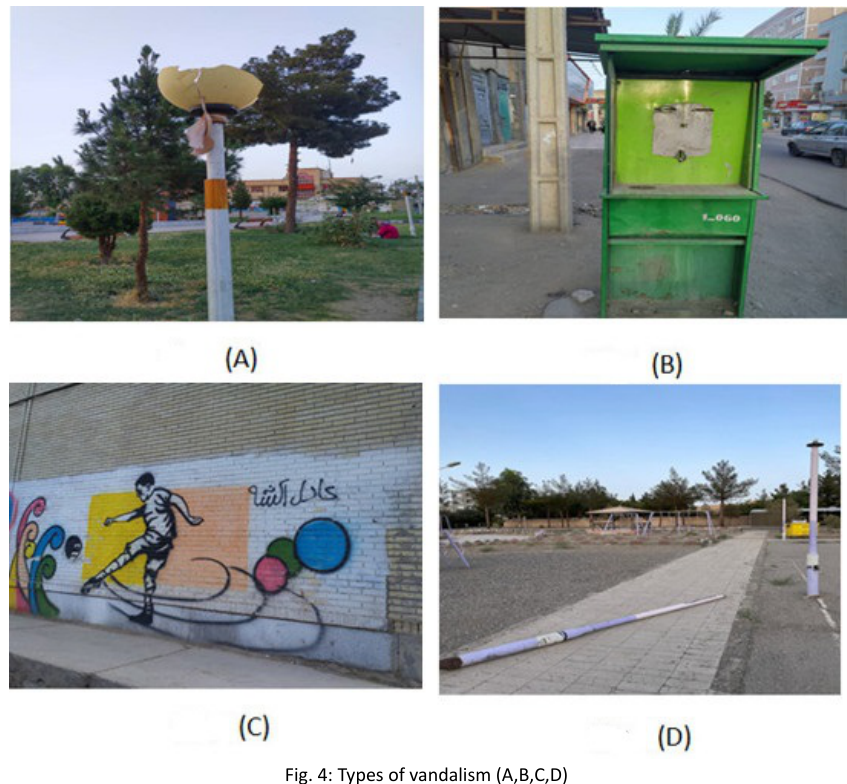
Fig. 4: Types of vandalism (A,B,C,D)